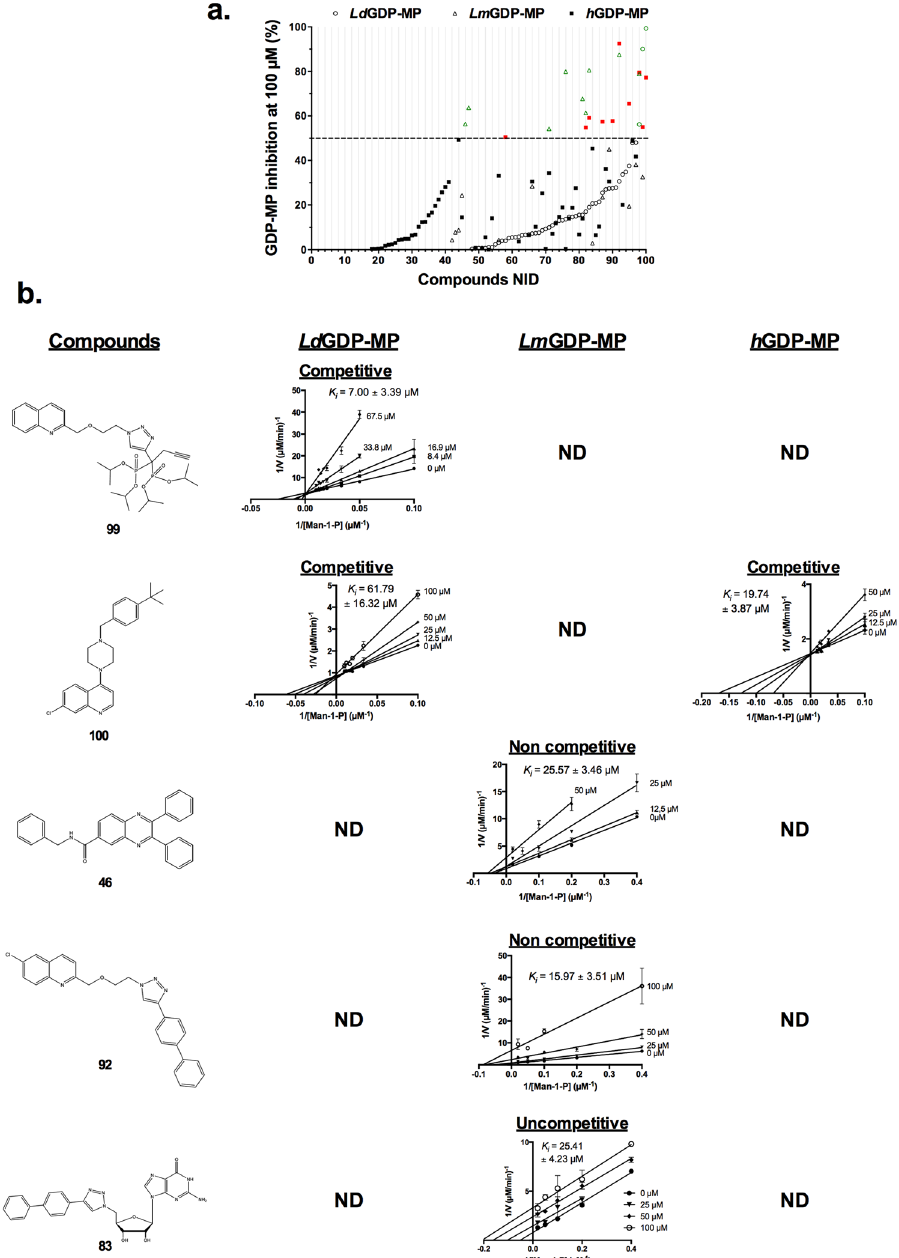
Figure 5. Evaluation of compound activities on Ld GDP-MP, Lm GDP-MP and h GDP-MP. ( a ) Percentage of Ld GDP-MP ( Ο ), Lm GDP-MP ( Δ ) and h GDP-MP ( ■ ) inhibition as a function of compounds numerical ID (NID). Each compound was used at 100 µ M. Compounds showing inhibition above 50% are represented in green and red for leishmanial and human GDP-MPs, respectively. For a question of readability, all values at 0% inhibition were removed. The results expressed correspond to the mean of three independent experiments. ( b ) Lineweaver plots double reciprocal plots 1/V = f(1/[Man-1-P]) of compounds 99 , 100 , 46 , 92 and 83 on Ld GDP-MP , Lm GDP-MP and h GDP-MP. Each compound was evaluated with a range of concentrations: 0–67.5 µ M for compound 99 on Ld GDP-MP, 0–50 µ M for compound 46 on Lm GDP-MP and compound 100 on h GDP-MP, and 0–100 µ M for compounds 83 and 92 on Lm GDP-MP and compound 100 on Ld GDP-MP. Man-1-P was used at 10–100 µ M for Ld GDP-MP and h GDP-MP and 2.5–50 µ M for Lm GDP-MP. GTP was held constant at 100 µ M for Ld GDP-MP and h GDP-MP, and 50 µ M for Lm GDP-MP. The formula of each compound is represented on the left of the figure. The compounds K i are indicated on each plot, as well as the type of inhibition. ND: no K i could be determined since the double reciprocal plots did not fit with any (competitive, non-competitive, uncompetitive or mixed) inhibition model. The results expressed correspond to the mean of three independent experiments ±